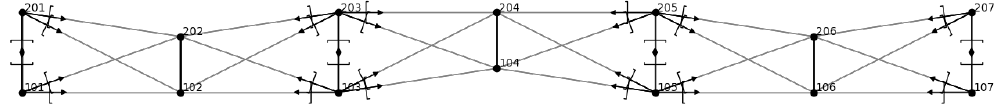
Figure 4. Location of the